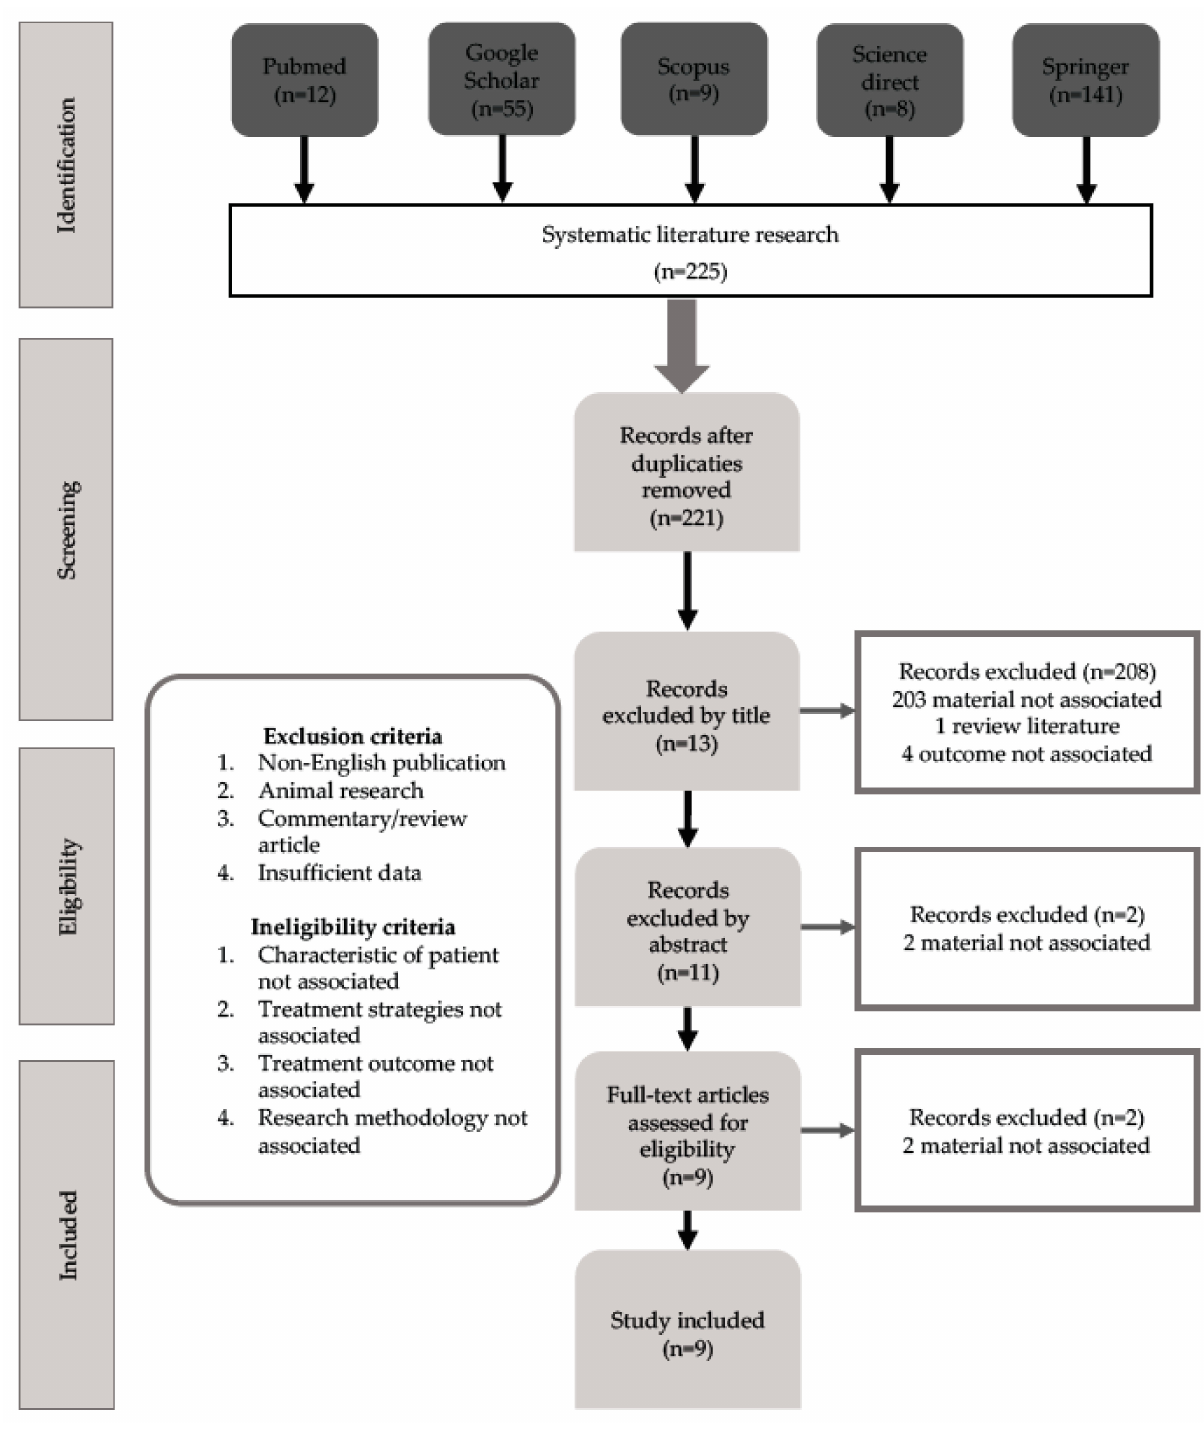
Figure 1. Prisma Flow